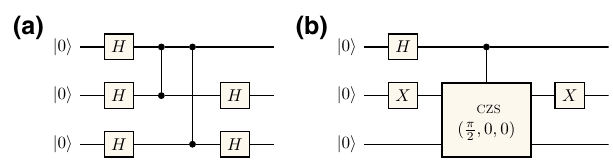
FIG. 4. Quantum circuits for generating the three-qubit GHZ √ state ( | 000 (cid:2) + | 111 (cid:2) ) / 2. (a) A circuit using single-qubit gates and two-qubit CZ gates. (b) A circuit using single-qubit gates and one CCZS